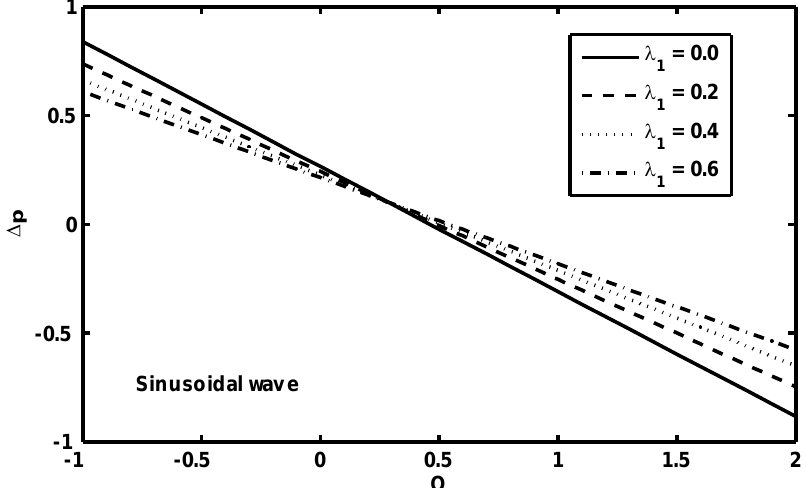
∆ p with Q for di ff erent values of λ p  with Q for different values of